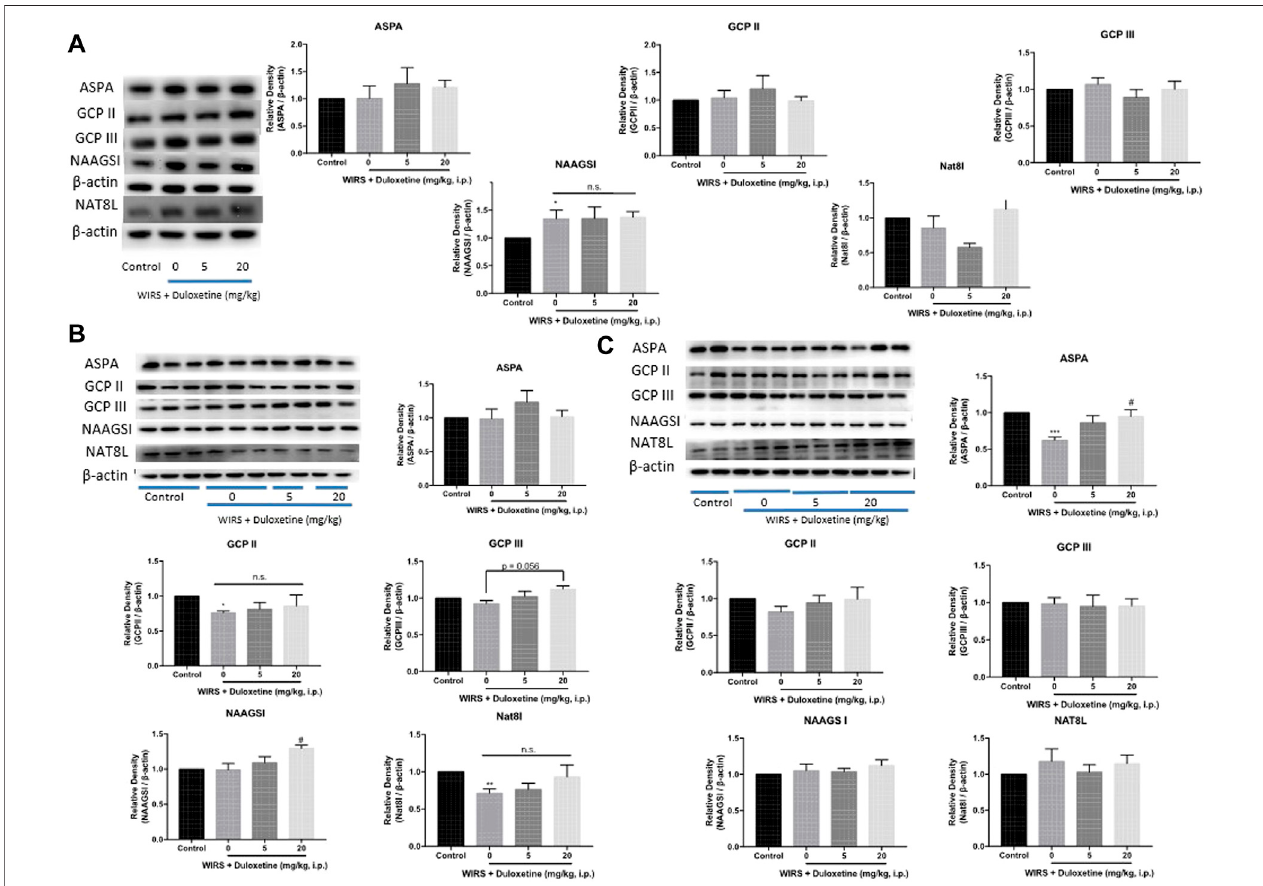
FIGURE 3 | Effect of pretreatment with duloxetine on NAA-related enzyme expression in CeA in rats exposed to 6 h/3 h/0.5 h of WIRS. (A) Representative immunoblots of ASPA/GCP II/GCP III/NAAGSI/Nat8l performed in CeA lysates. Western blotting showed that duloxetine pretreatment had no effect on the expression leveloftheseenzymesinCeAafter6 hofWIRS( n =5incontrol,5 mg/kgduloxetineand20 mg/kgduloxetinegroup, n =6in0 mg/kgduloxetinegroup). (B) WIRSfor3 h decreased the expression of GCP II and Nat8l in CeA, and duloxetine did not modulate the expression of these two enzymes ( n = 5 per group), while pretreatment with 20 mg/kg duloxetine increased NAAGSI and slightly increased GCP III expression in CeA exposed to WIRS, which did not change by WIRS ( n = 6 per group). (C) WIRS for0.5 h decreased the expression ofAPSAin CeA, and pretreatmentwith 20 mg/kg duloxetine reversed thisdecrement( n =6 per group). ASPA/GCP II/GCP III/ NAAGSI/Nat8l was normalized to β -actin. Values are expressed as means ± SEM. * p < 0.05, ** p < 0.01,*** p < 0.001, compared with control group, compared with control group, # p < 0.05, compared with WIRS + vehicle group.